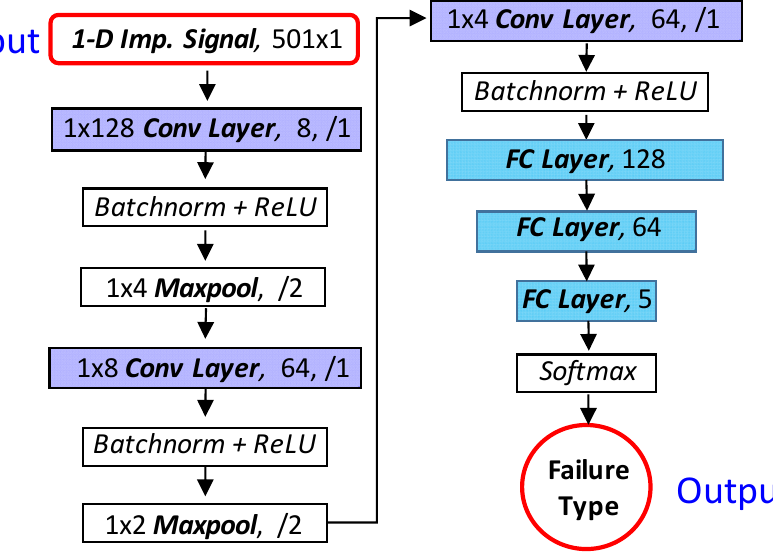
Figure 5. The block diagram of the 1D CNN model.